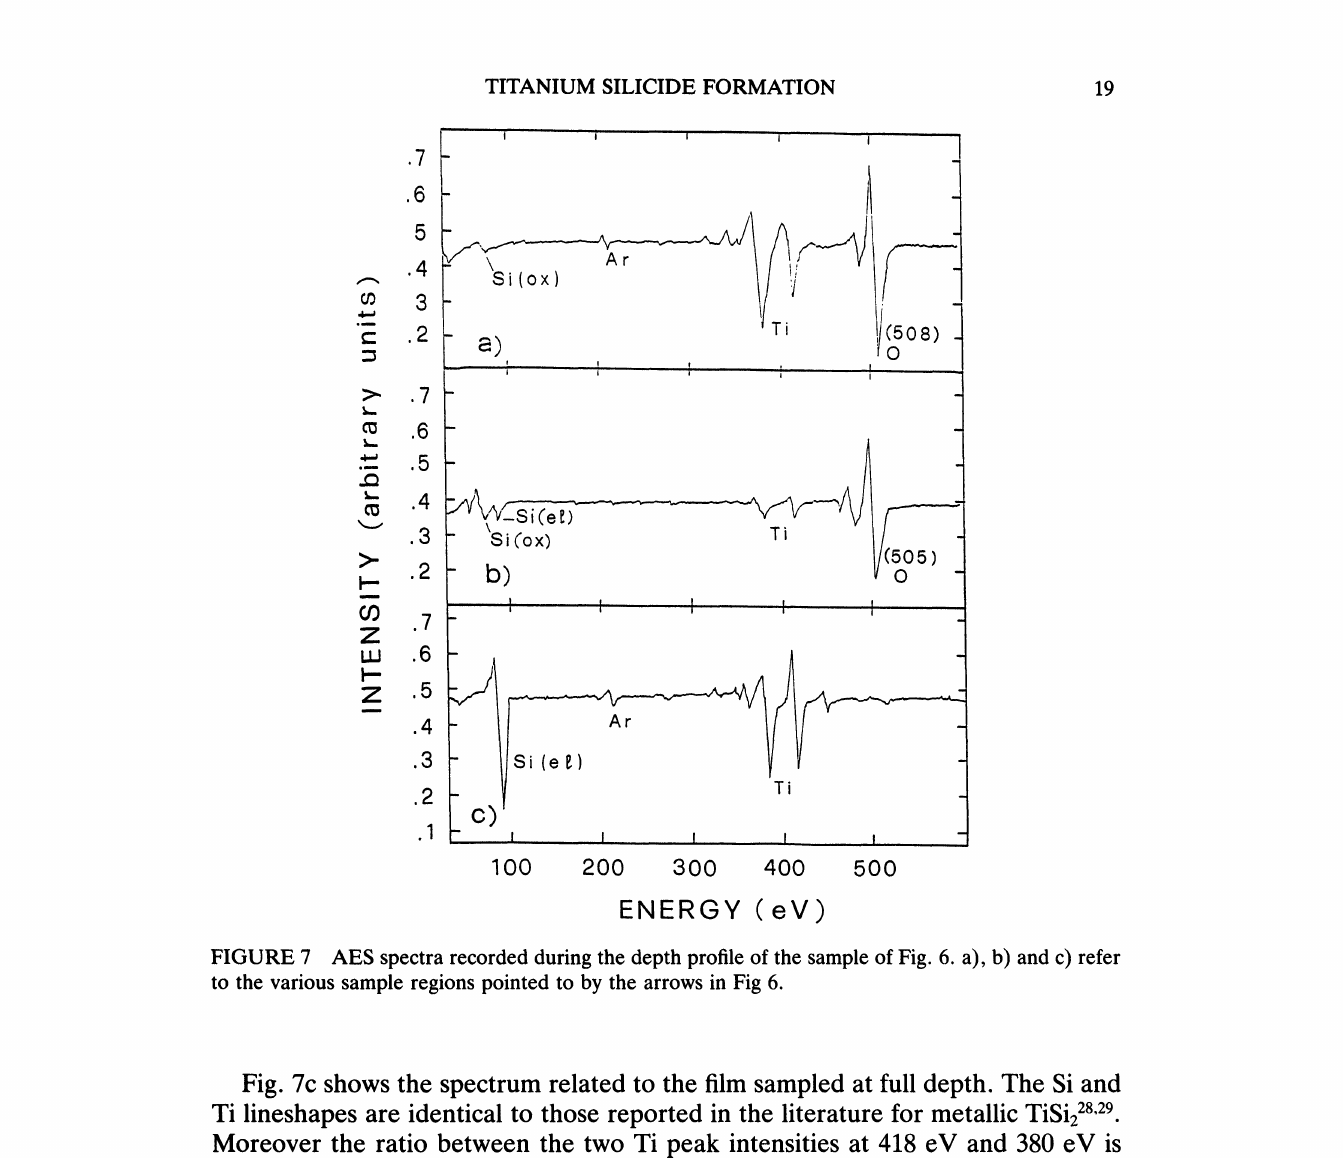
FIGURE 7 AES spectra recorded during the depth profile of the sample of Fig. 6. a), b) and c) refer to the various sample regions pointed to by the arrows in Fig